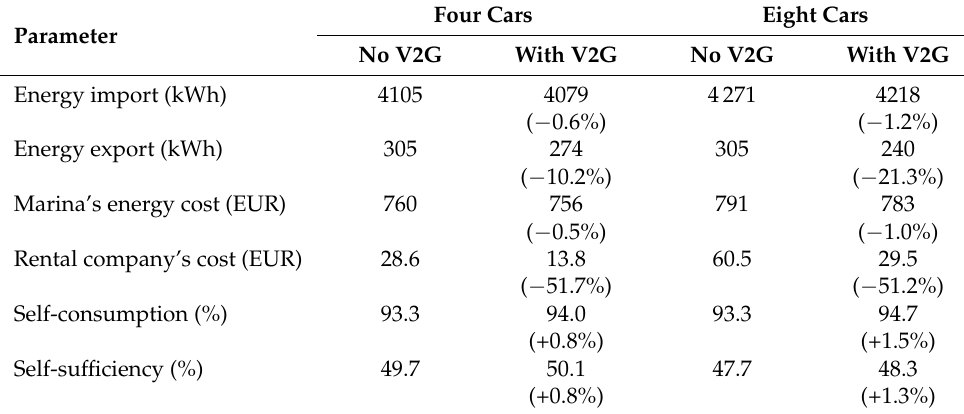
Table 5. Simulation results for bidirectional power flow with increased PV capacity.